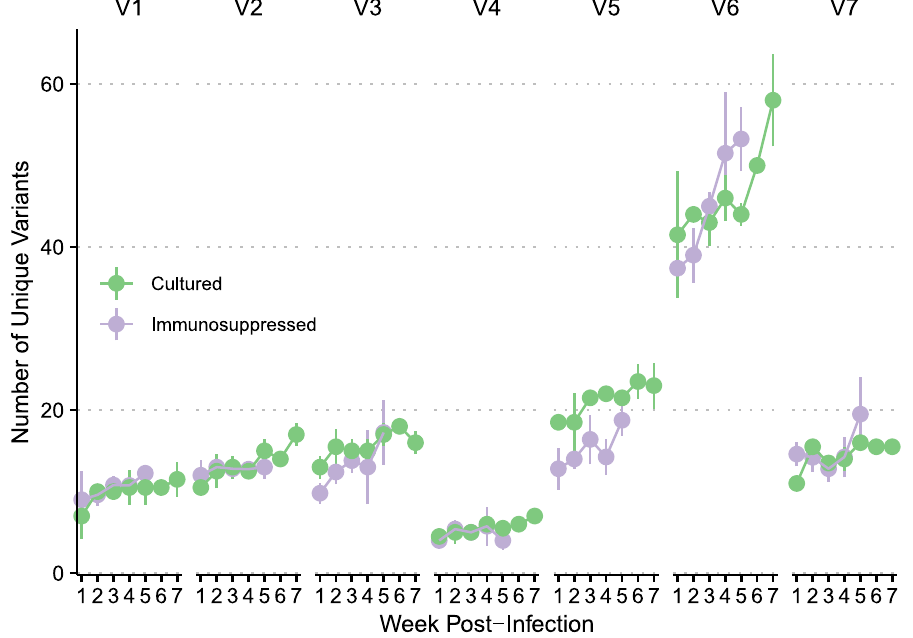
Fig 5. Comparison of number of unique V region alleles detected in samples passaged in immunosuppressed rabbits and in culture. X-axis depicts weeks post-infection. Dots represent the mean number of unique variants at that time point, with lines demonstrating standard